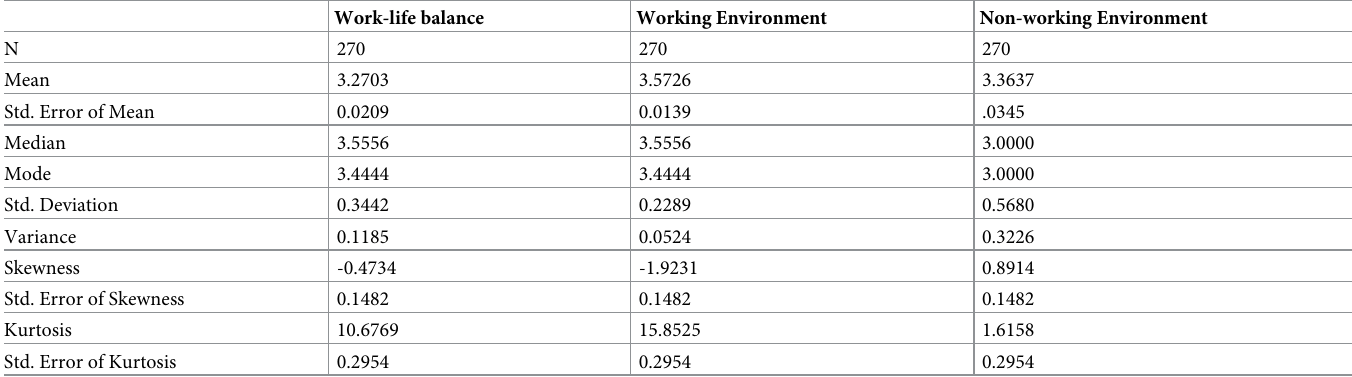
Table 3. Descriptive statistics of independent and dependent